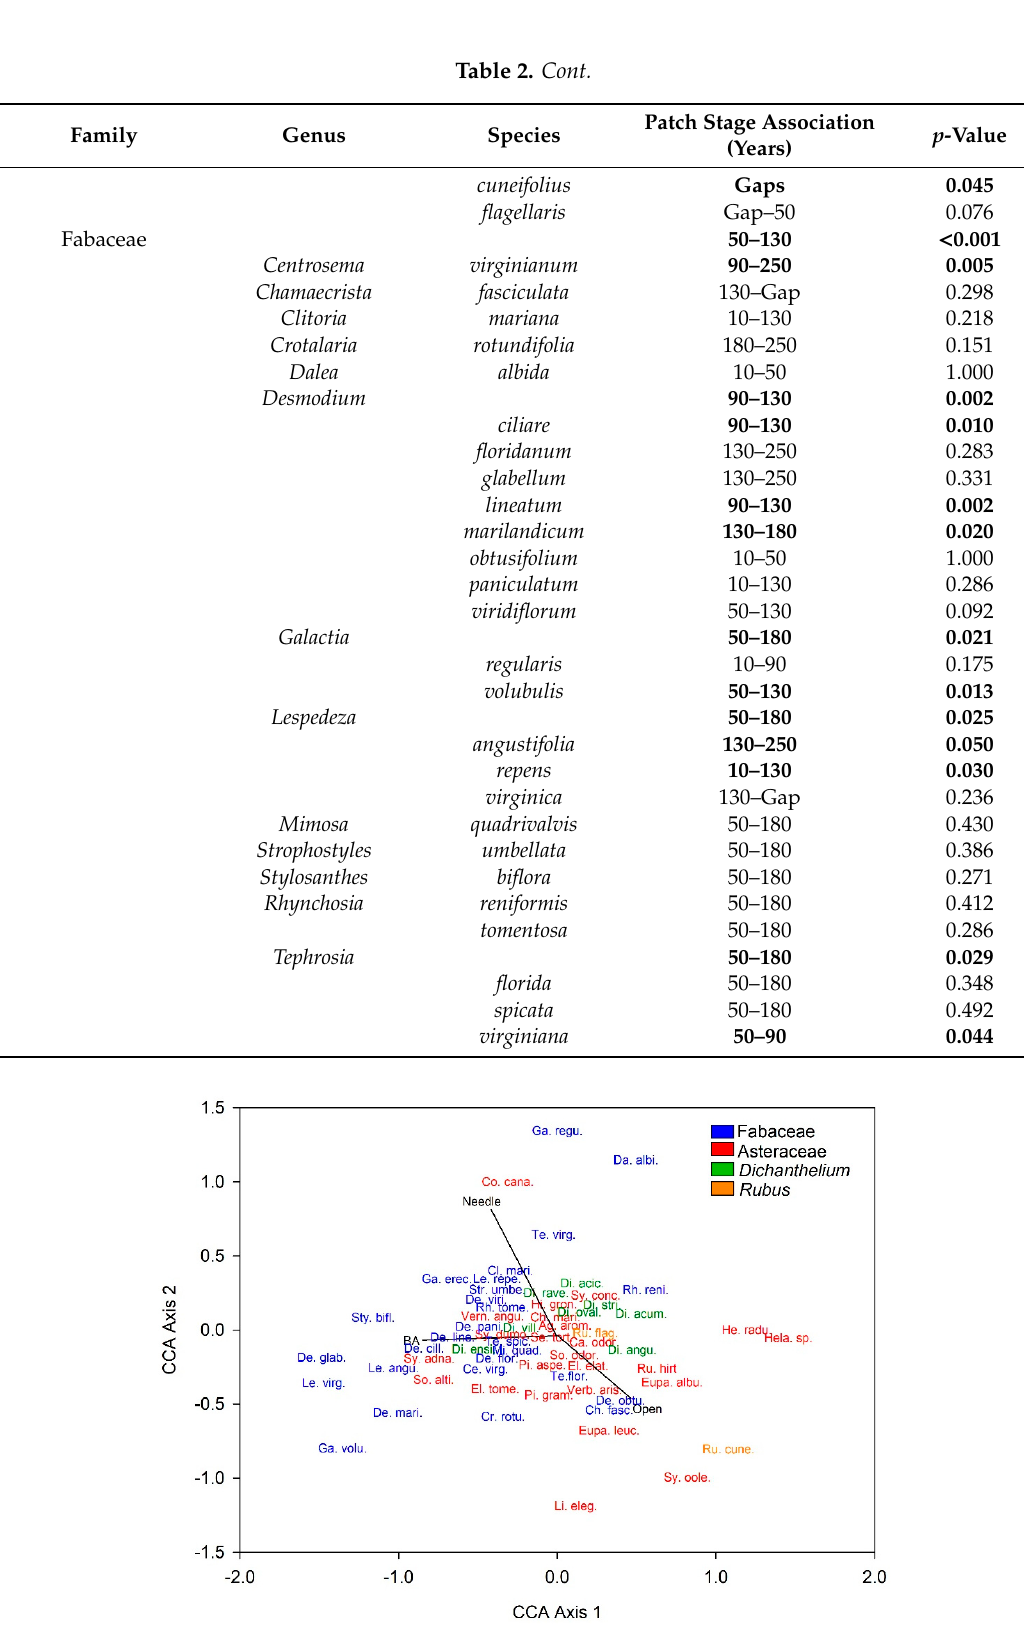
Figure 9. CCA ordination graph of the ground-layer vegetation genus or families’ relative cover in relation to three environmental characteristics: pine litter accumulation, basal area, and canopy openness (light levels). Each point represents a species color-coded into a family or genus, as indicated by the legend.